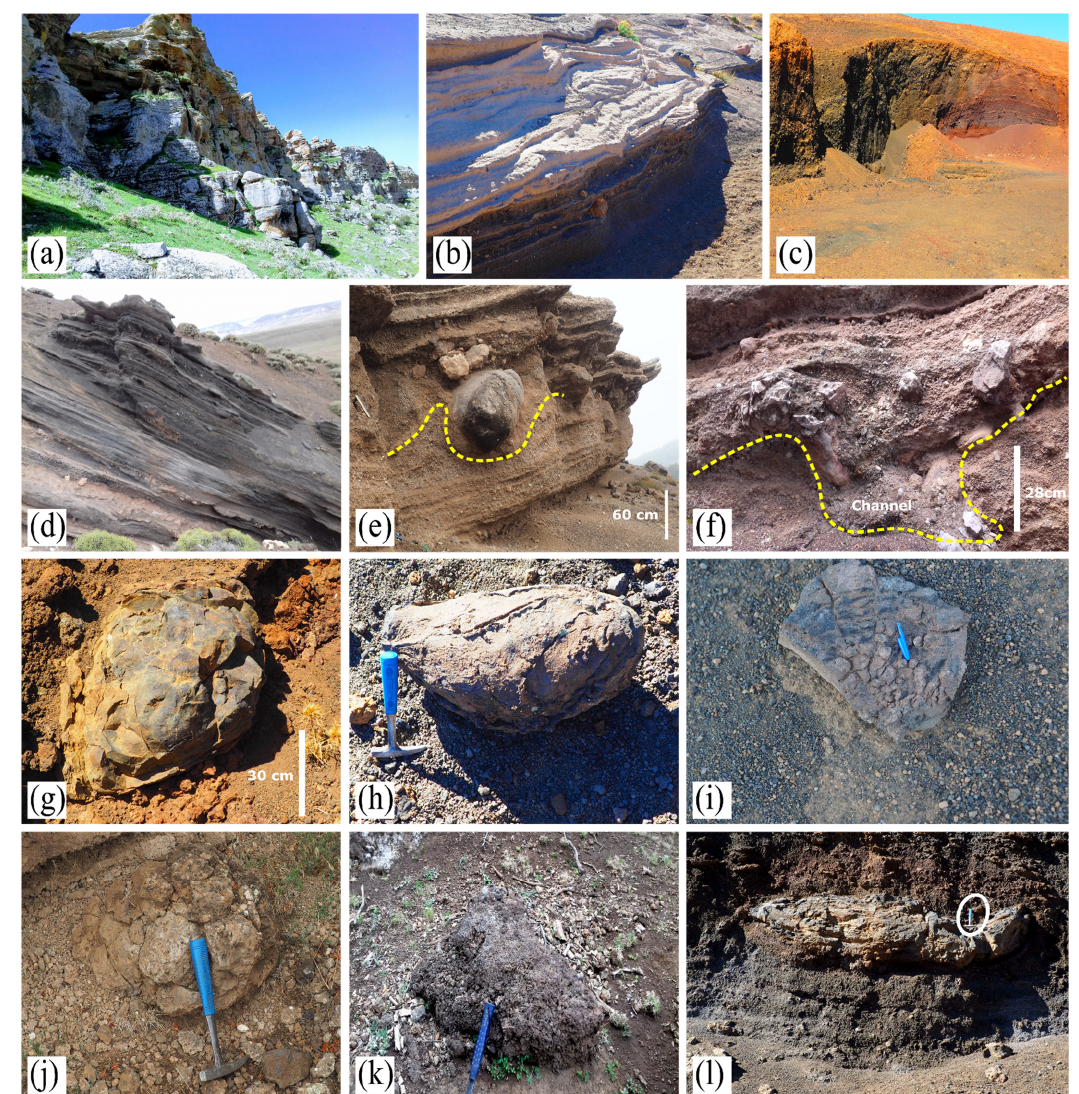
Figure 11. The various textures of pyroclastic deposits and blocks of the MAVF: ( a ) pyroclastic deposit of Boubalghattene maar; ( b ) base surge deposit in the southwestern part of Timahdite vol- cano; ( c ) pozzolan quarry in the southeastern part of Aguelmam Sidi Ali volcano; ( d ) black scoria deposit in the northern part of Lachmine Lakbir cone; ( e ) load figure in the NNW ring of Lach- mine N’kettane maar (Ln 1); ( f ) channel in Lachmine N’kettane maar (Ln 1); ( g ) ellipsoidal ball bomb in the red scoria of Timahdite cone; ( h ) spindle bomb found in the northern part of Hebri; ( i ) bread crust bomb found in the western cone of Hebri; ( j ) cauliflower bomb found in the NNE ring of Lachmine N’kettane maar; (k) lava shreds found in the northern part of Lachmine N’kettane cone (Ln 1) ; ( l ) fragment of clastogenic lava within the black scoria of the cone of Timahdite.